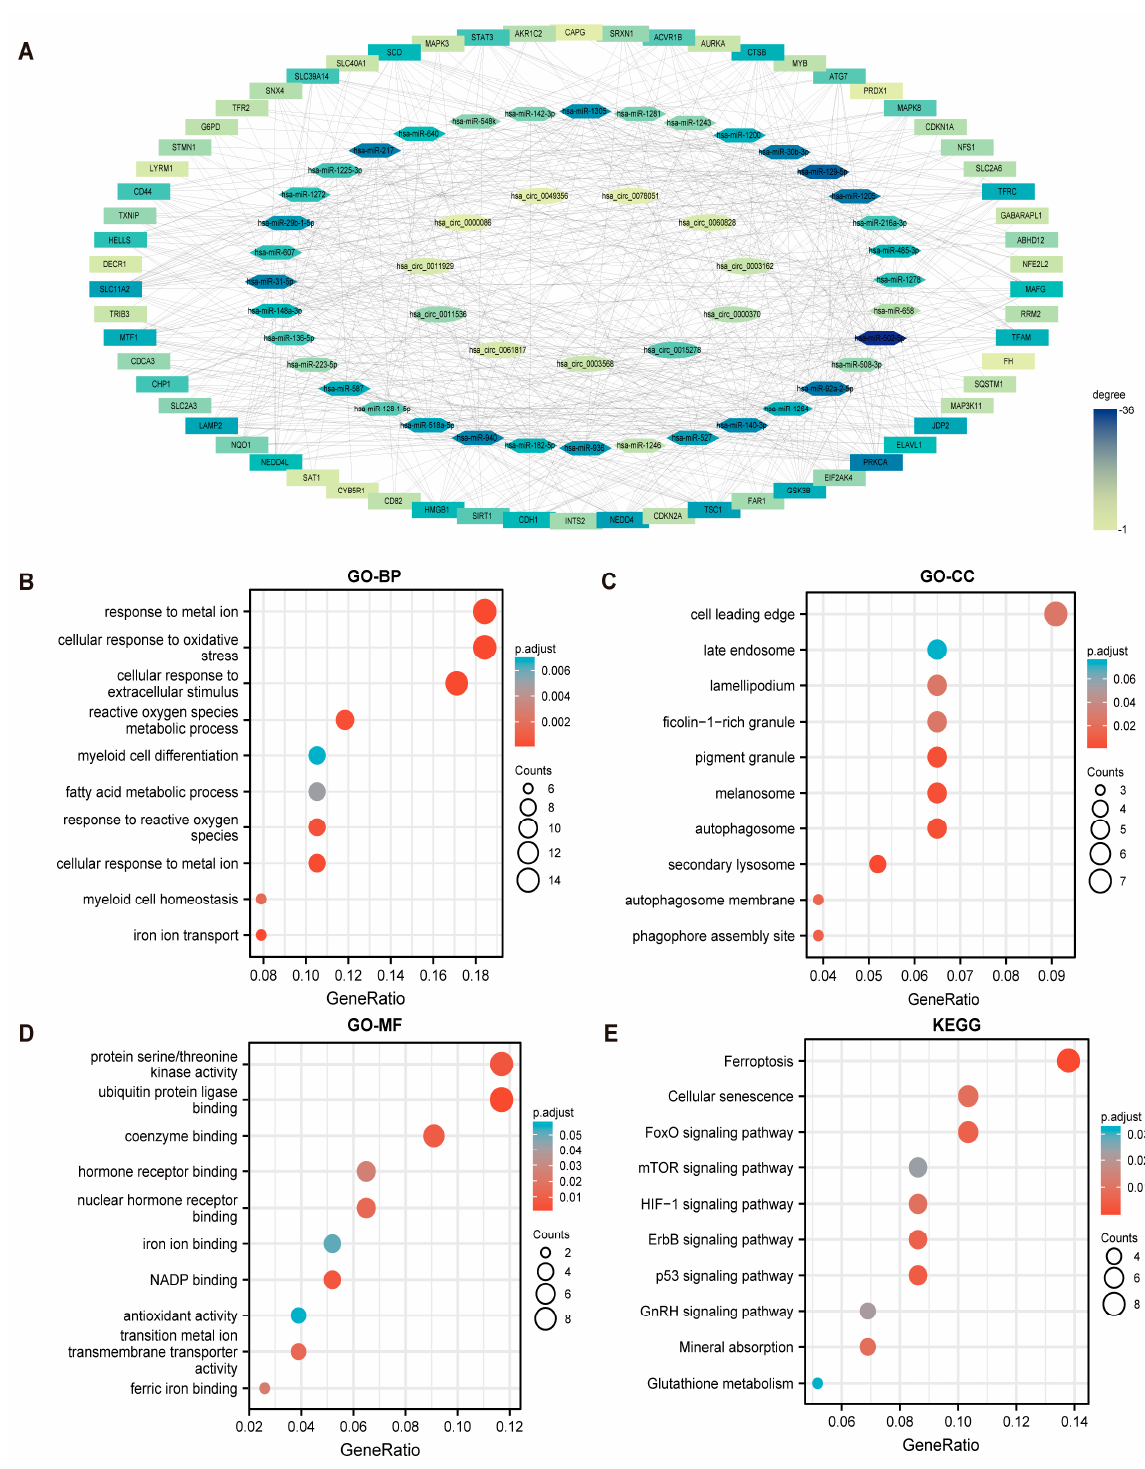
Figure 2. Construction of ceRNA regulatory network and GO and KEGG enrichment analysis. ( A ) The ceRNA regulatory network of circRNAs − miRNAs − -73 FerRGs in AML. Ovals indicate circRNAs, hexagons indicate miRNAs, and rectangles indicate FerRGs. The shade of color represents the degree of connectivity. ( B – E ) GO and KEGG functional enrichment analyses of 73 FerRGs in the ceRNA network. ( B ) The GO enrichment of BP. ( C ) The GO enrichment of CC. ( D ) The GO enrichment of MF. ( E ) The enrichment analysis of KEGG pathways. ceRNA, competitive endogenous RNA; BP, biological processes; CC, cellular components; MF, molecular functions.